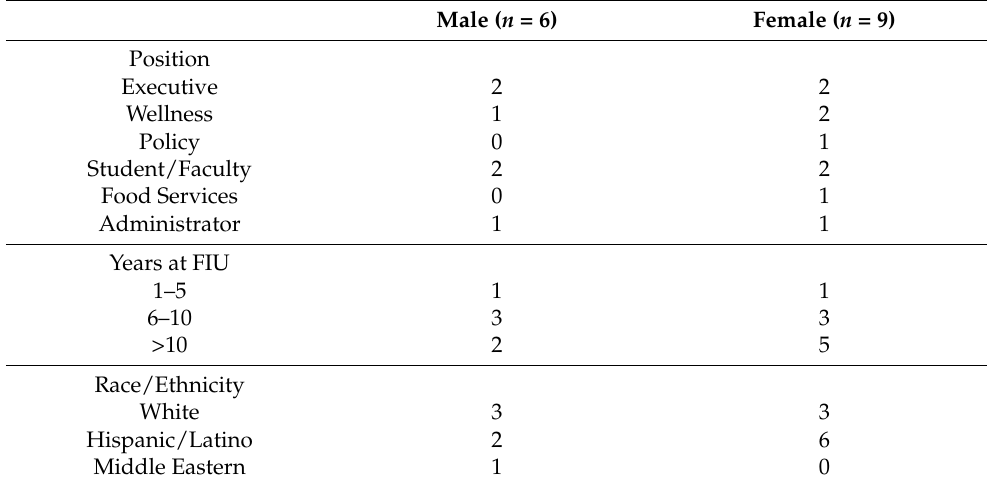
Table 2. Demographic characteristics of interviewees, n =